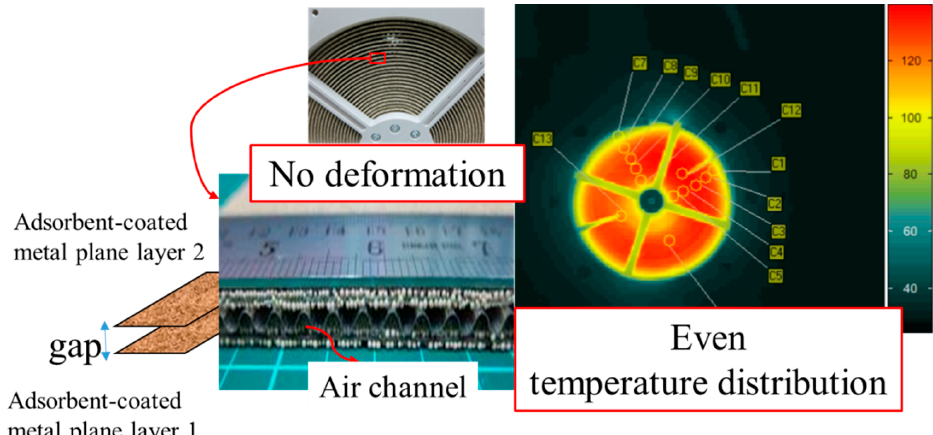
Figure 10. ETAU without air channel and gaps.